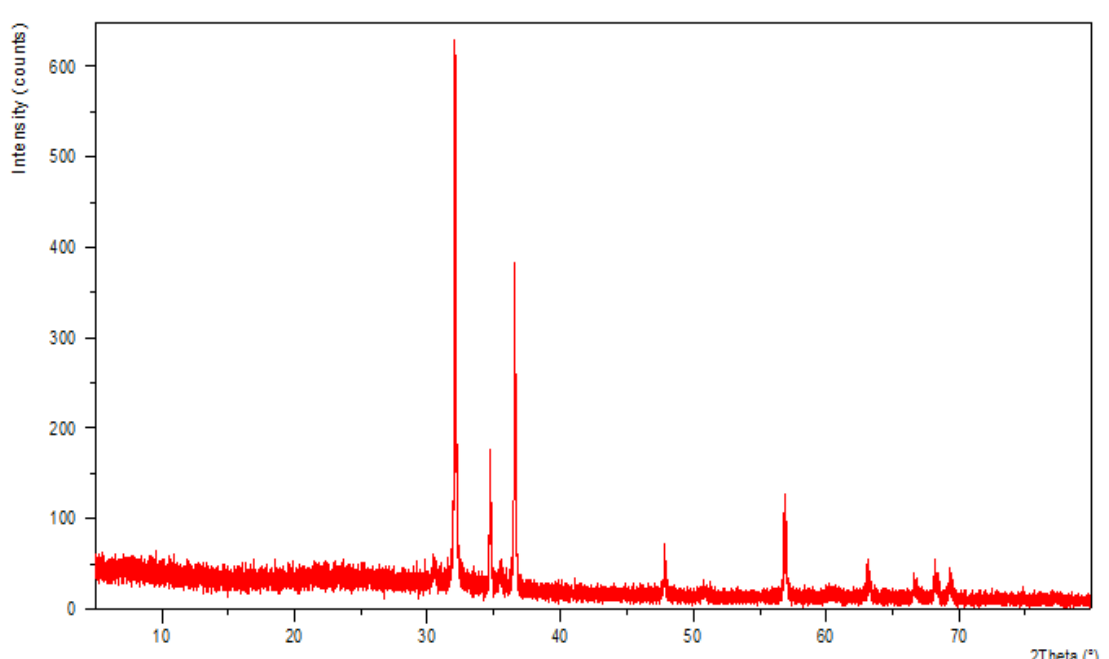
Figure 4. ZnO ionic alignments in a wurtzite crystal structure, Adapted from Ref. [30]. Yellow represents zinc and grey oxygen.